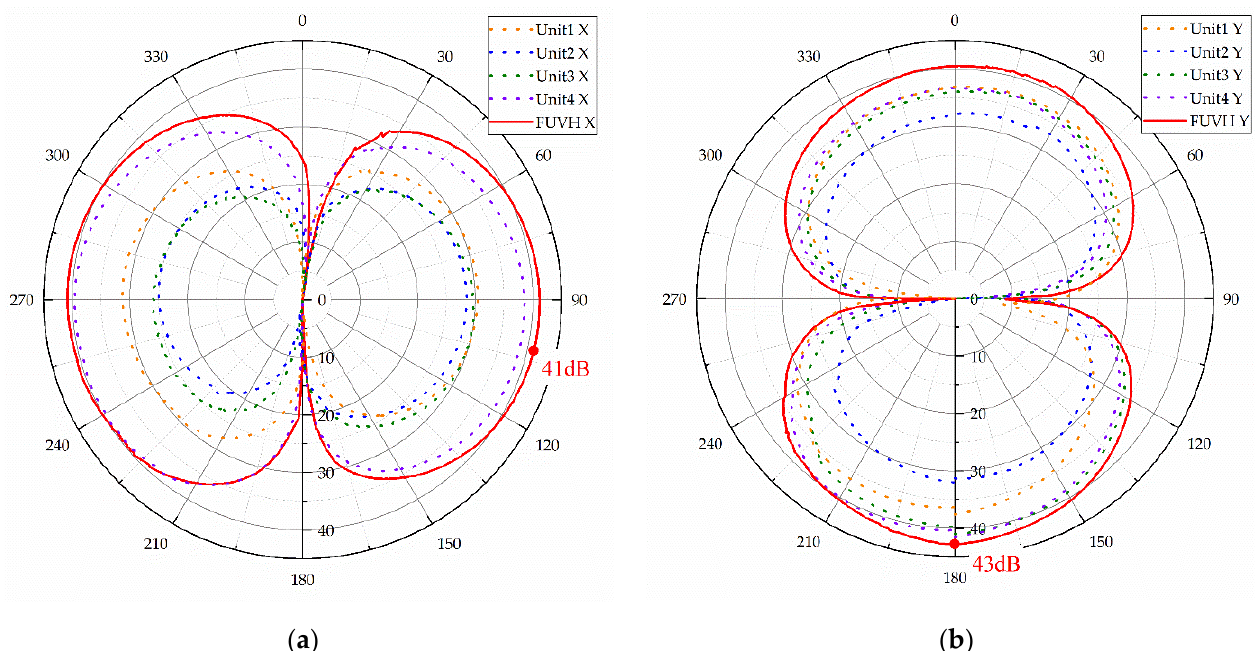
Figure 14. The results of the directivity pattern test: ( a ) the concave point depth of the X channel is 41 dB; ( b ) the concave point depth of the Y channel is 43 dB.